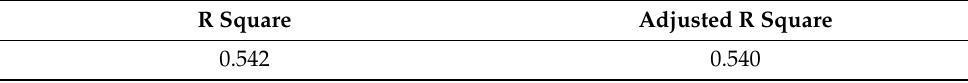
Table 5. Goodness of fit test results of the model.